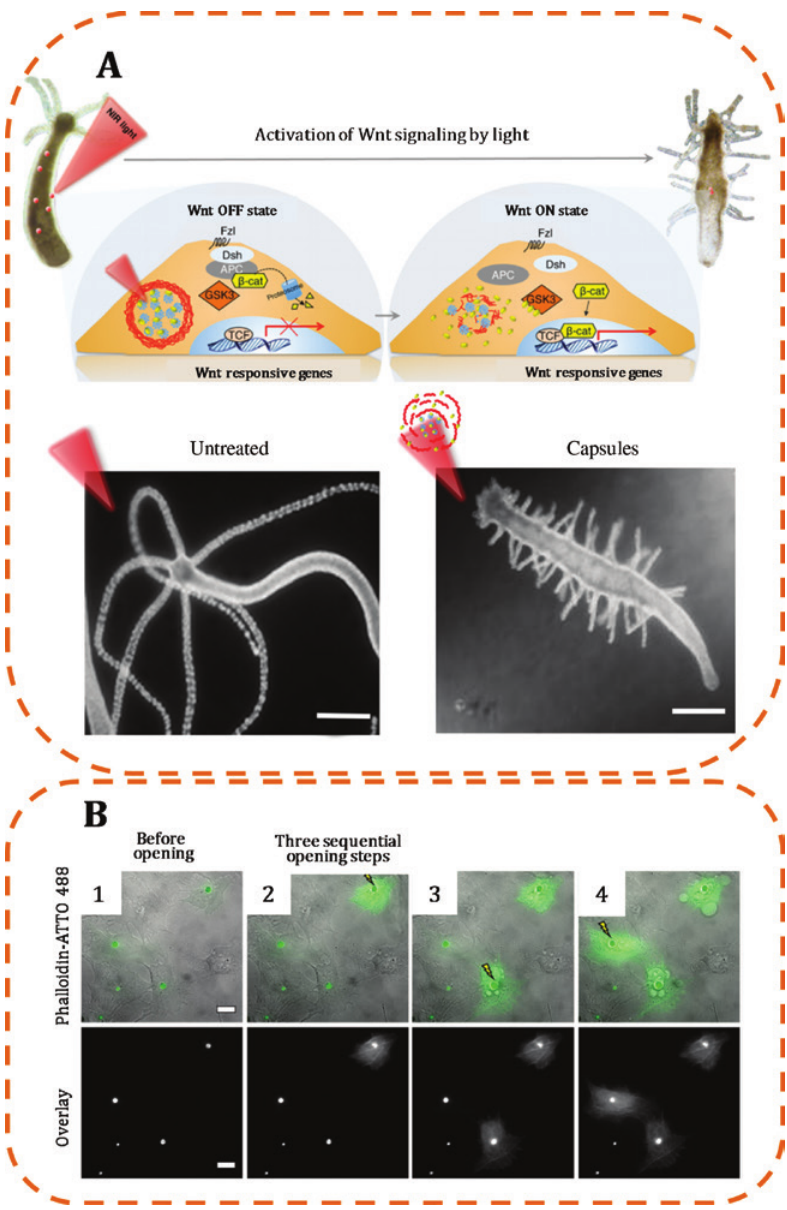
Figure 11: Light-induced release of bioactive compounds from composite polymer carriers. (A) NIR-triggered activation of Wnt signalling pathway, (top) schematic diagram of experimental procedure, (left bottom) untreated animal, irradiated, (right bottom) animal treated with light-sensitive capsules and irradiated. Scale bars correspond to 500 μ m. (B) Fluorescence and overlay (fluorescence + bright field channel) images of cells incubated with light-sensitive capsules. In (2–4), images are shown after three illumination steps. The scale bar corresponds to 20 μ m. Reprinted from [9, 199]. Copyright 2016 American Chemical Society; Copyright 2018 by Wiley-VCH Verlag GmbH & Co. KGaA,